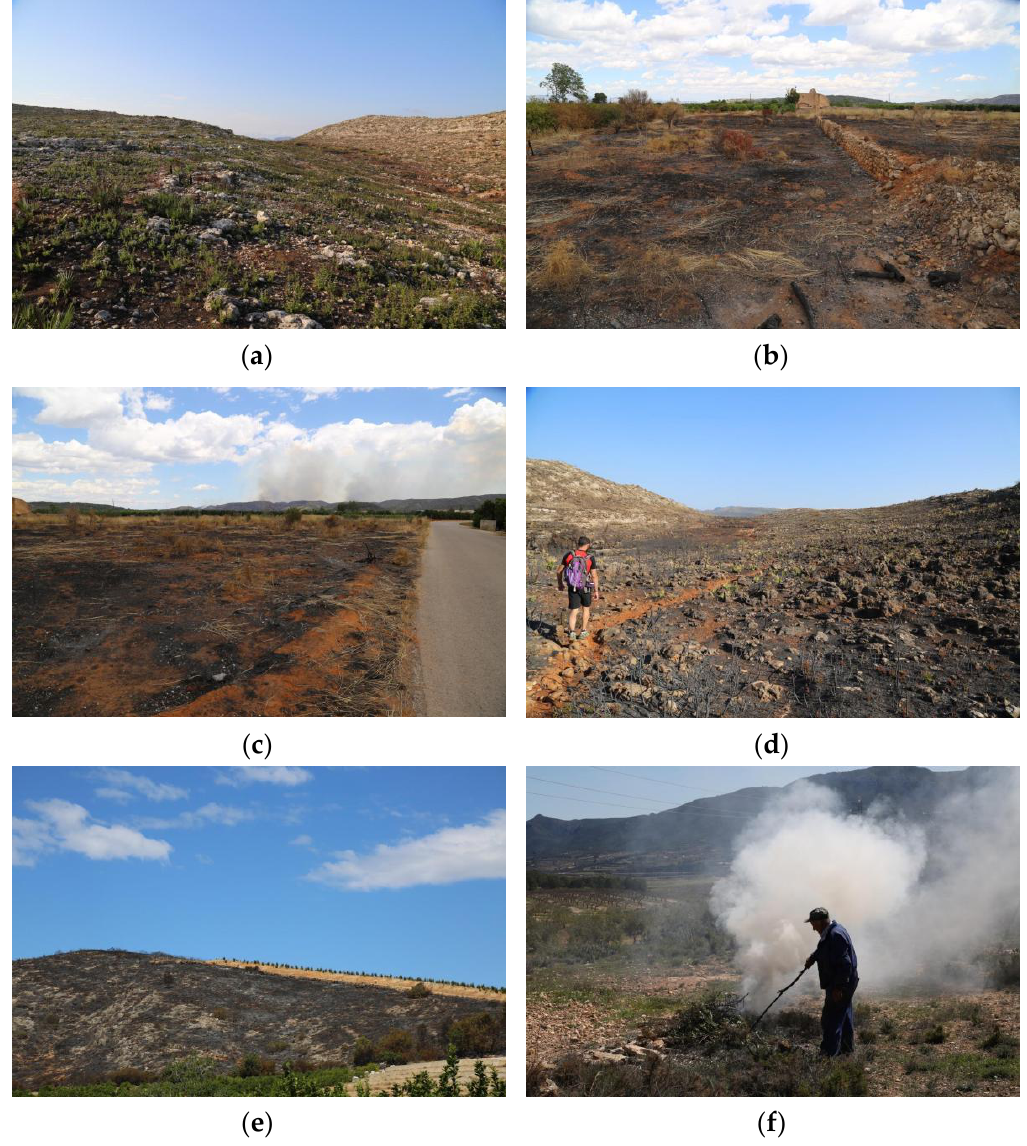
Figure 4. Forest fire in Carcaixent. June 2016. View in September 2016. Quick recovery thorough the spotters such as thorny oak - Quercus coccifera ( a ); recently abandoned fields in densely populated areas results in fires (Carcaixent, June 2016) ( b and c ); and forest fire in Carcaixent, June 2016. One week after the fire (see dwarf palm - Chamaerops humilis already sprouting) ( d ); new plantations (citrus) and forest fires. The opening of new roads for the new plantations contributes to enhance fire risk ( e ); and fire was a tool for farmers. Less prescribed fires result in higher biomass and higher fire risk ( f ).